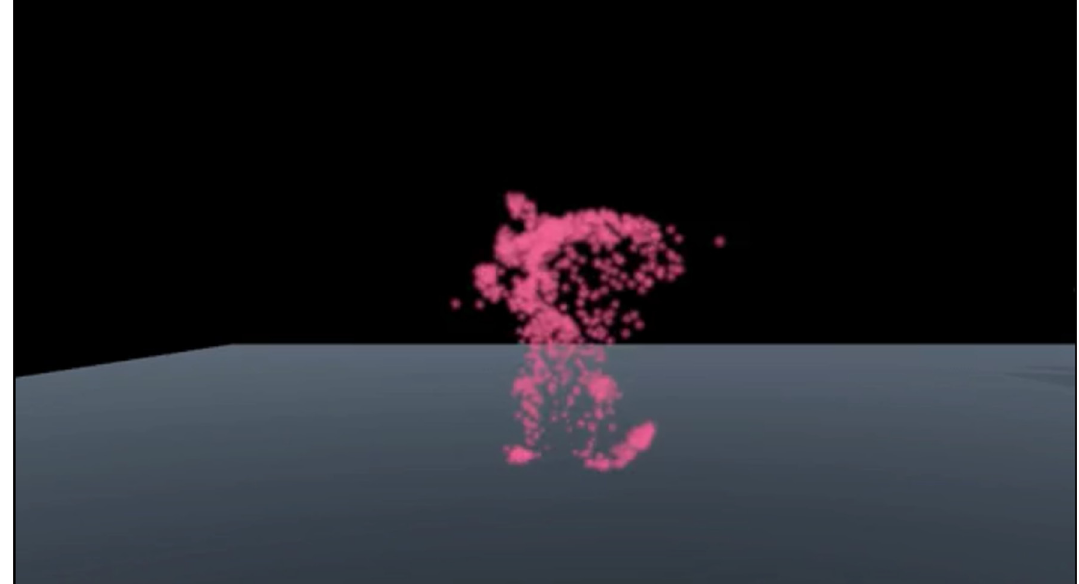
Figure 6: Abstracted particle